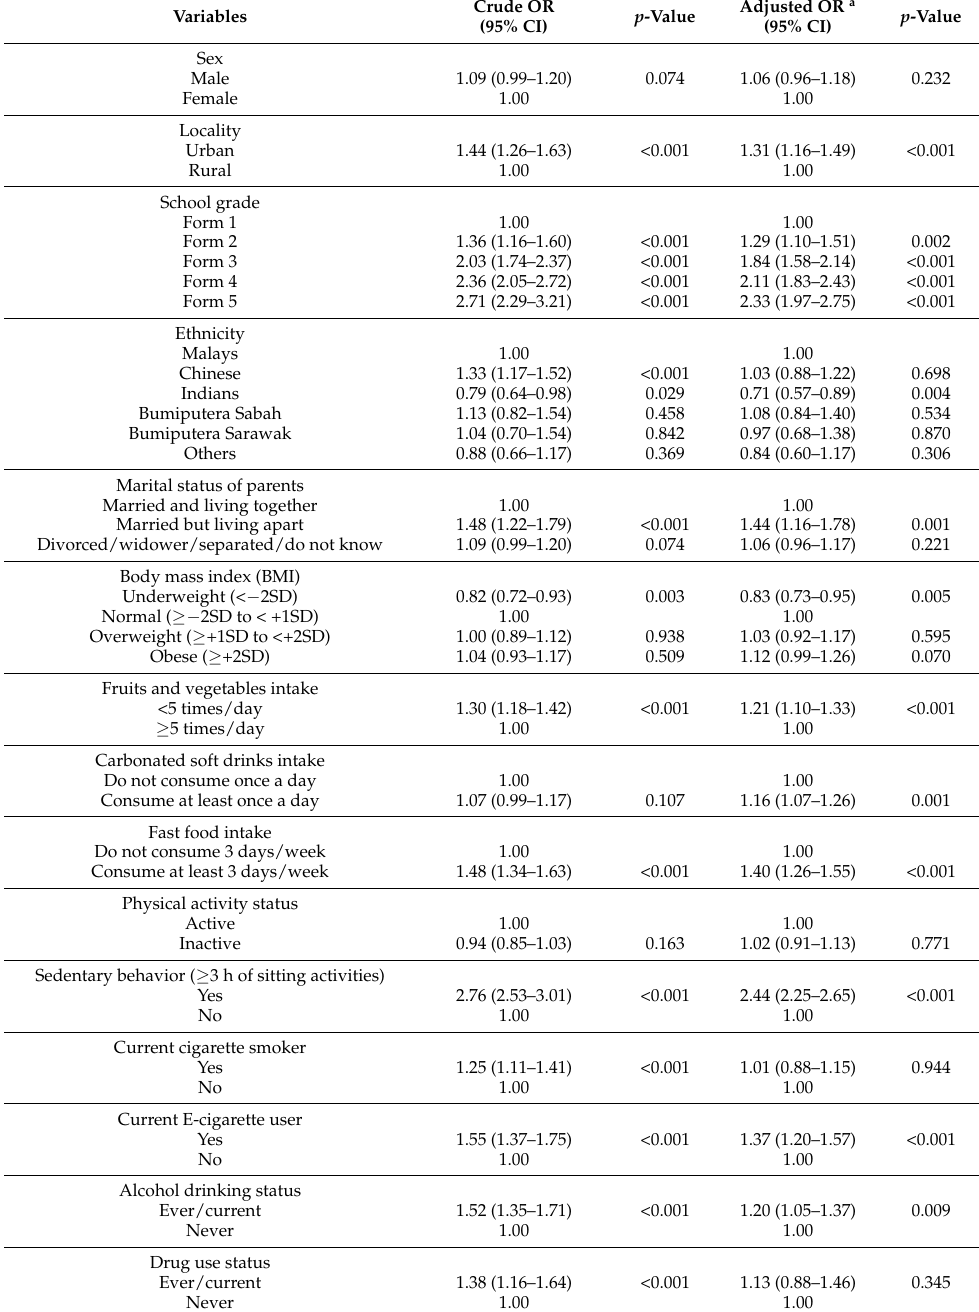
Table 3. Univariable and multivariable logistic regression analyses for internet addiction among Malaysian adolescents by demographic and lifestyle characteristics.